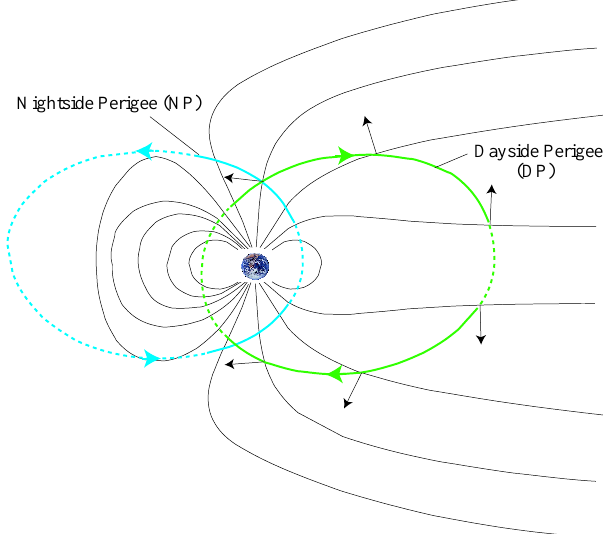
Fig. 1. The two types of orbits selected for this study, denoted Nightside Perigee (NP) and Dayside Perigee (DP), respectively. The solid parts denote the portions over the polar cap and into the polar cusps. The black arrows show the orientation of the ˆ e s -axis used to define the sense of the convection in the GSE (X,